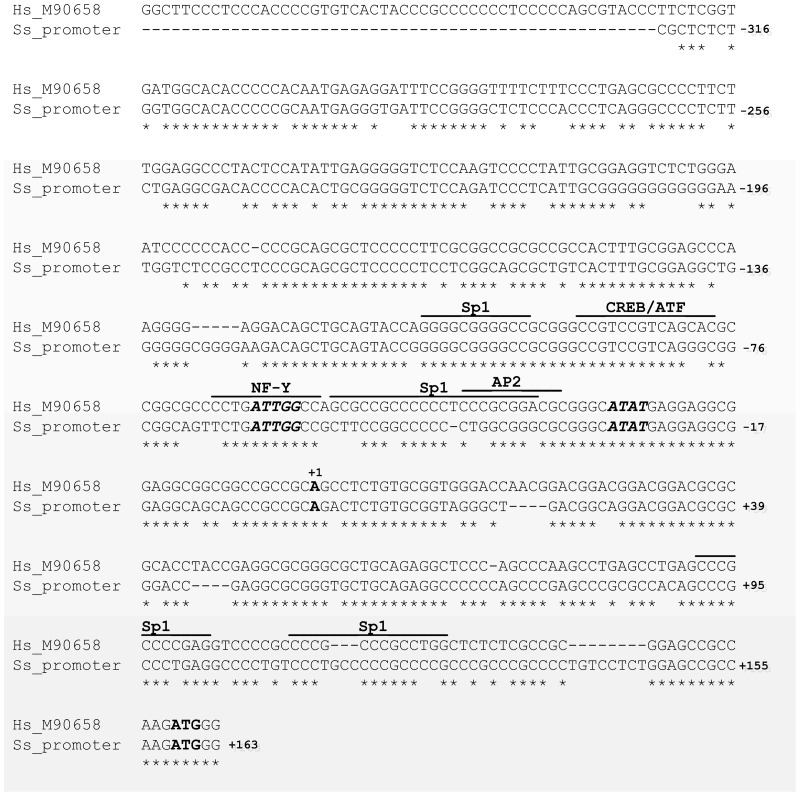
Comparison of the cloned porcine ATP1A3 promoter with the human ATP1A3 promoter.Nucleotides are numbered with reference to the putative transcriptional start site (+1). Lines indicate putative transcription factor binding sites. The CCAAT and TATA boxes are indicated in bold italics. Bold ATG indicates the start site of translation. Hs: Homo sapiens, Ss: Sus scrofa. Following the abbreviation of the species, the accession numbers are shown.